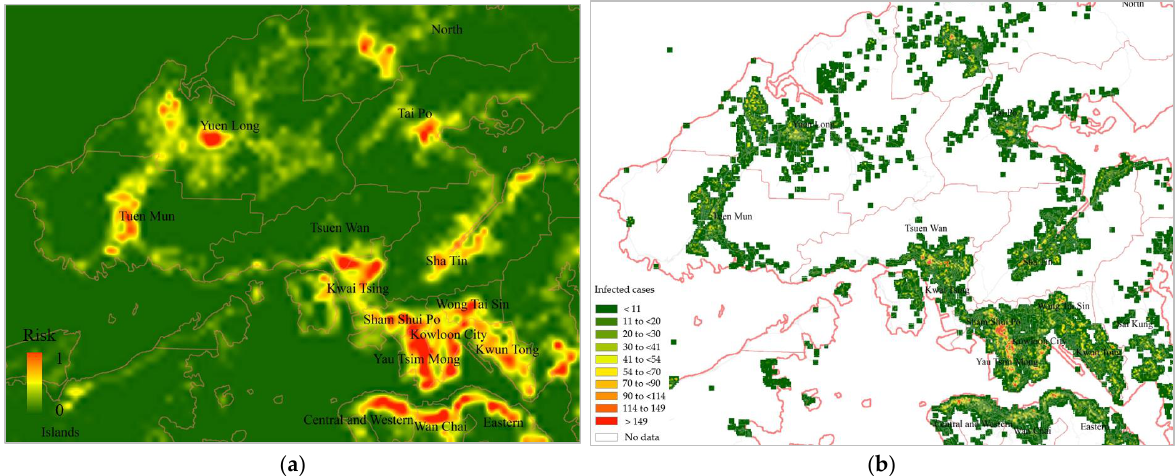
Figure 5. Mapped infection risk in Hong Kong using the proposed regression model. ( a ) Predicted infection risk map; ( b ) Actual observed infected cases as reference.